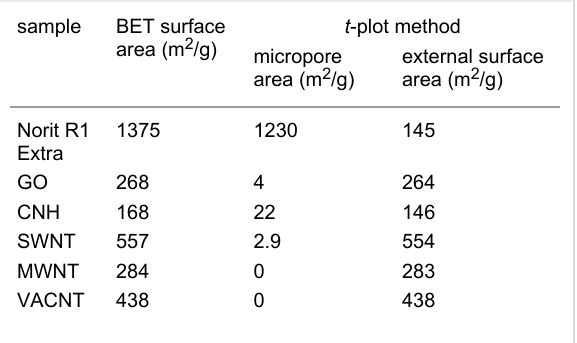
Table 2: BET surface area and t -plot analysis of the different adsor- bents.